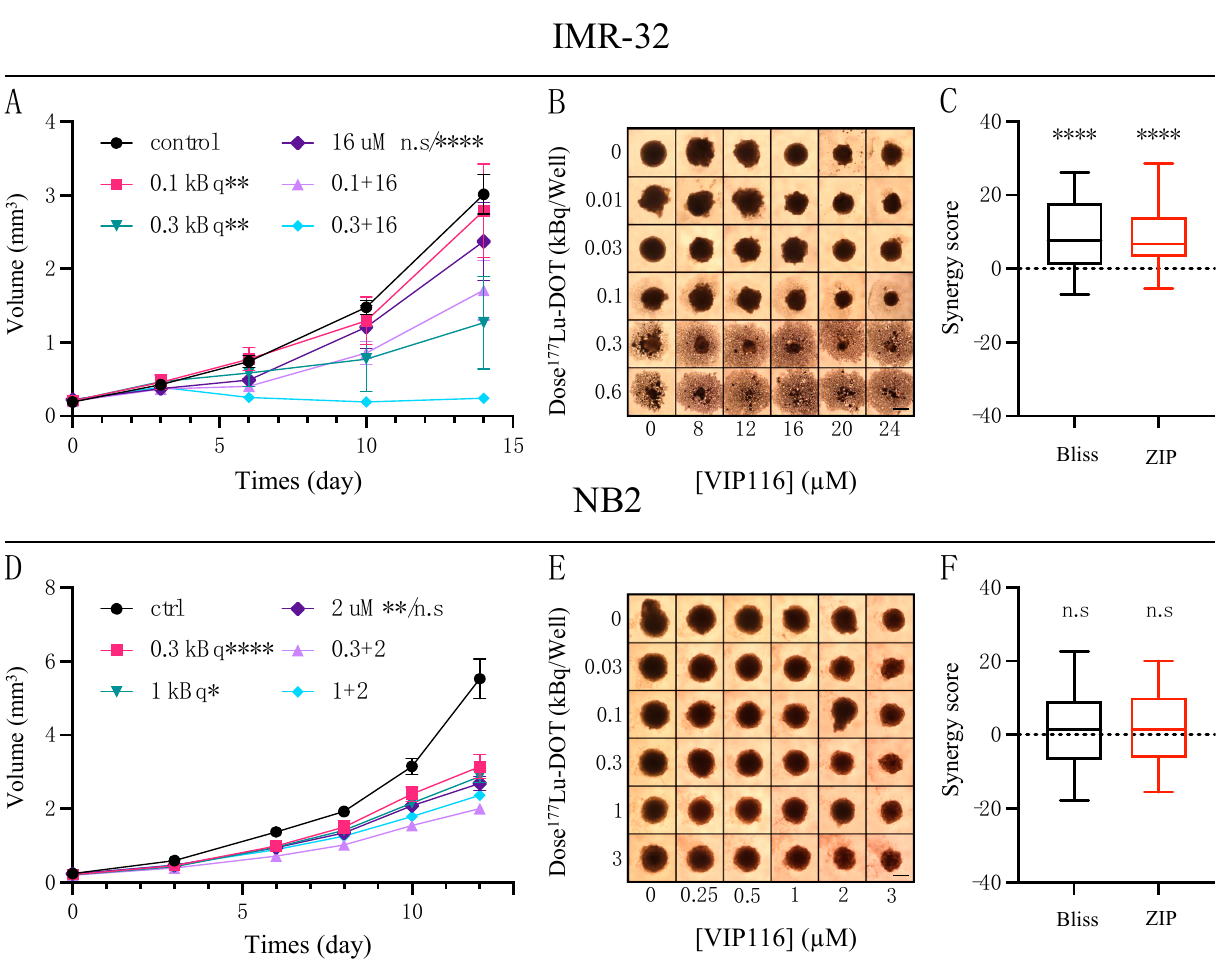
Figure 3. Spheroid combination therapy. ( A ) Representative graph (mean ± SD, n ≥ 4) of IM R-32 spheroids treated with 0.1 or 0.3 kBq 177 Lu-DOTATATE and 16 µ M VIP116. p -value indications next to monotherapy legends are in comparison to the corresponding combination group(s). ( B ) Representative IM R-32 spheroid images at day 14. Scale bar = 500 µ m. ( C ) Synergy values for IM R-32 spheroid combinations using Bliss (black) or ZIP (red) synergy models. Values below 0 indicate antagonism, 0 indicates additive effect and above 0 indicates synergy. Pooled data from two independent experiments (n = 50) are presented as mean with box (25th to 75th percentile) and whiskers (min to max). ( D ) Representative graph (mean ± SD, n ≥ 4) of NB2 spheroids treated with 0.3 or 1 kBq 177 Lu-DOTATATE and 2 µ M VIP116. p -value indications next to monotherapy legends are in comparison to the corresponding combination group(s). ( E ) Representative NB2 spheroid images at day 12. Scale bar = 500 µ m. ( F ) Synergy values for NB2 spheroid combinations using Bliss (black) or ZIP (red) synergy models. Values below 0 indicate antagonism, 0 indicates additive effect and above 0 indicates synergy. Pooled data from two independent experiments ( n = 50) are presented as mean with box (25th to 75th percentile) and whiskers (min to max). n.s. = not significant, * = p < 0.05, ** = p < 0.01 and **** = p <